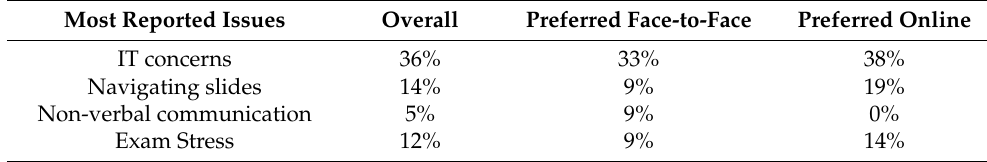
Table 1. Summary of differences in perception between students who preferred online or face-to-face